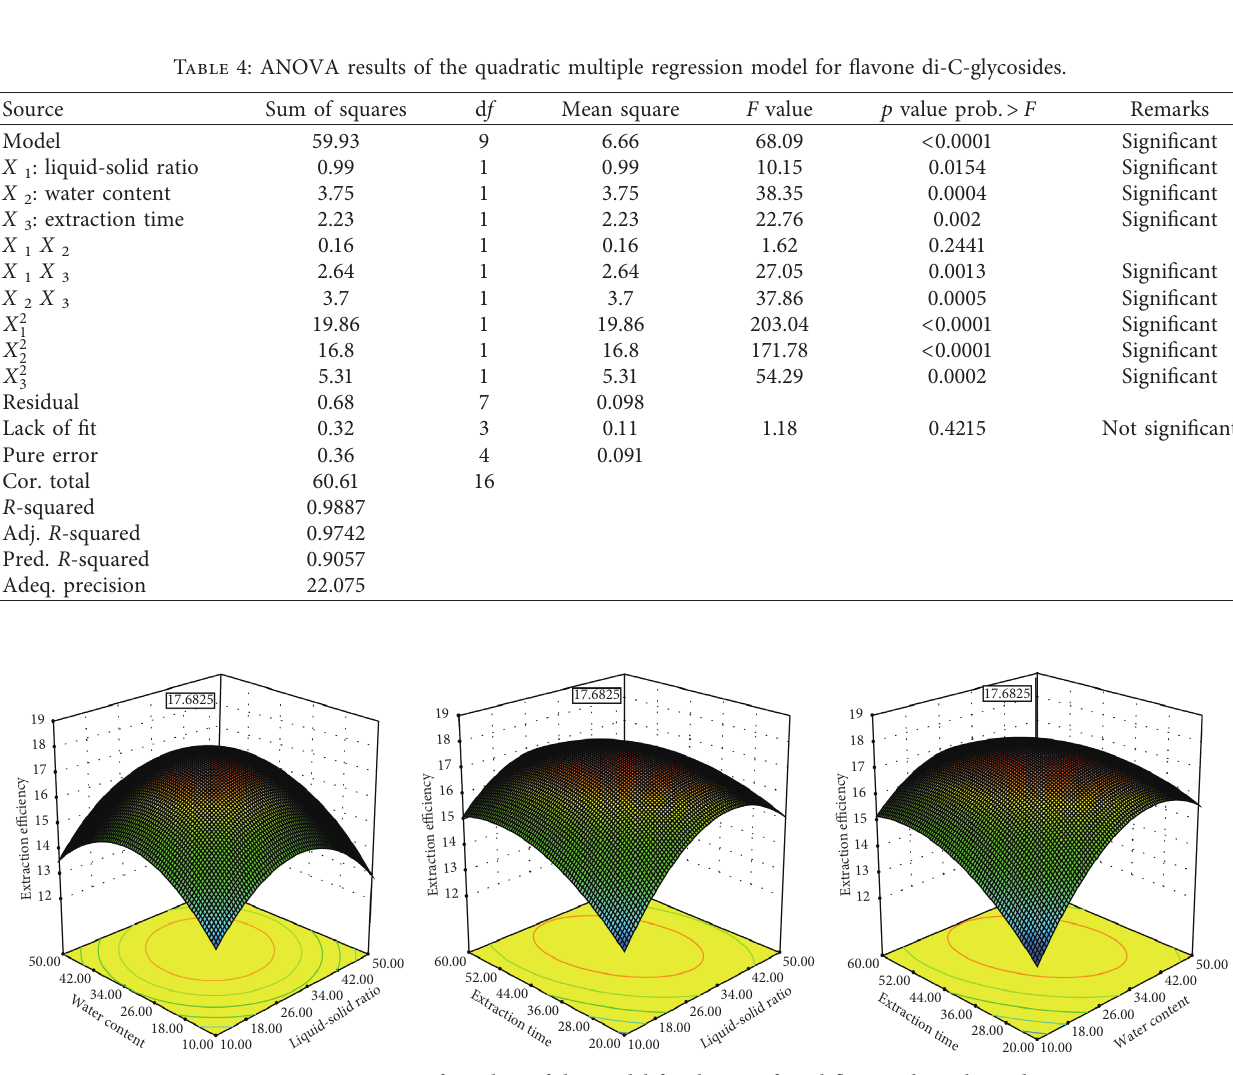
Figure 4: 3D response surface plots of the model for the EE of total flavone